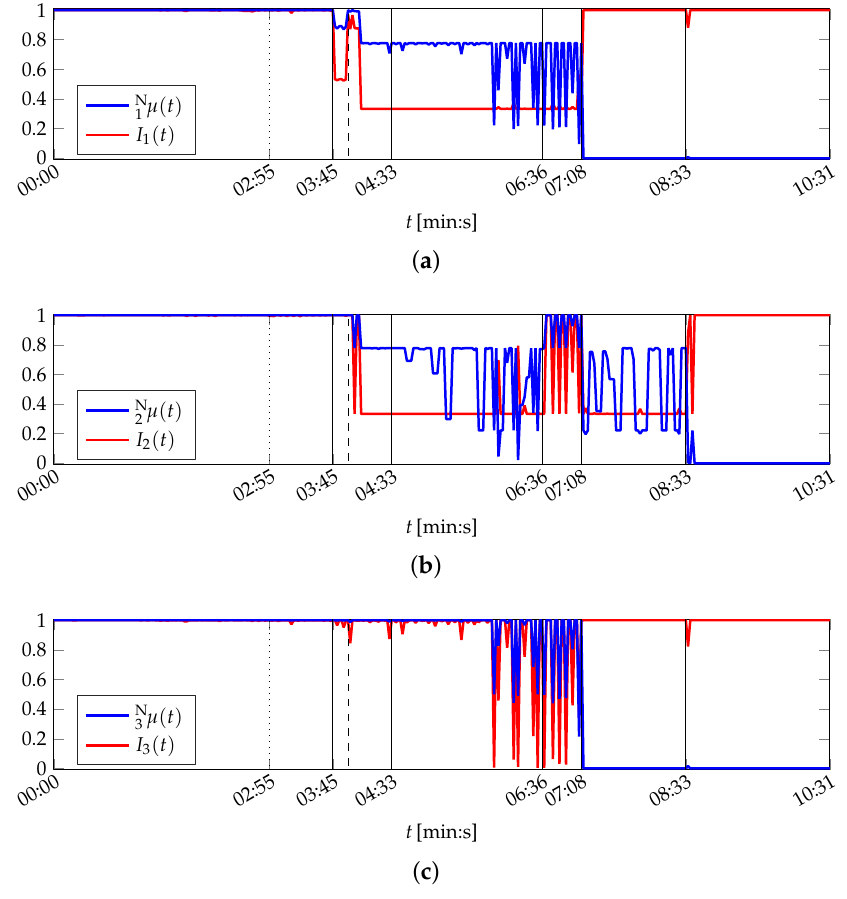
Figure B2. Attribute health evaluation over time during manipulated operation of the printing unit demonstrator (PU manip ). Plots ( a – c ) show attribute healths N a µ ( t ) and their corresponding importances I a ( t ) . Training data was acquired up to 2:55(min:s) (100 plate cylinder revolutions, cf. the black dotted line). Variations in the curves are due to effects of the operation itself and result from manipulations or faults, marked by vertical black lines (cf. Table A3). Attribute composition according to Table 4. ( a ) Attribute 1: Motors; ( b ) Attribute 2: Contact Pressure; ( c ) Attribute 3: Motor